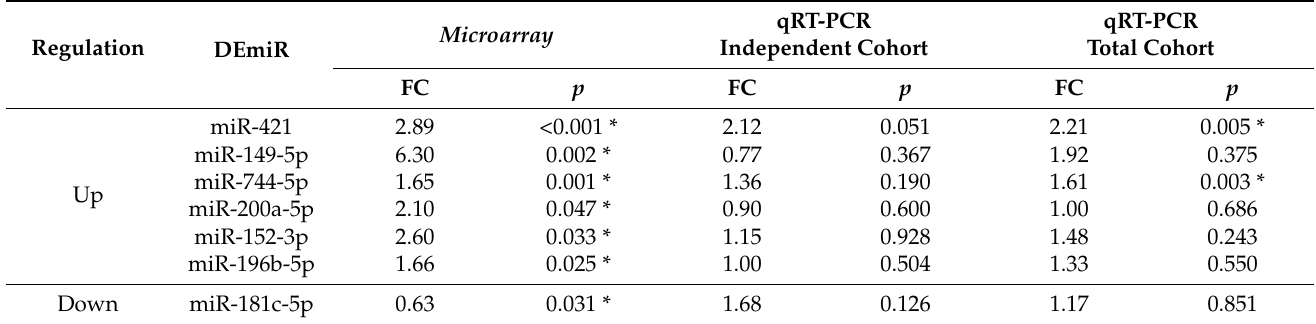
Table 2. List of seven differentially expressed miRNAs (DEmiRs) identified by microarray analysis ( n = 11) when comparing tumor samples of patients with metastatic in relation to localized disease and chosen for validation in the independent ( n = 13) and in the total cohort of patients ( n = 24) by qRT-PCR.